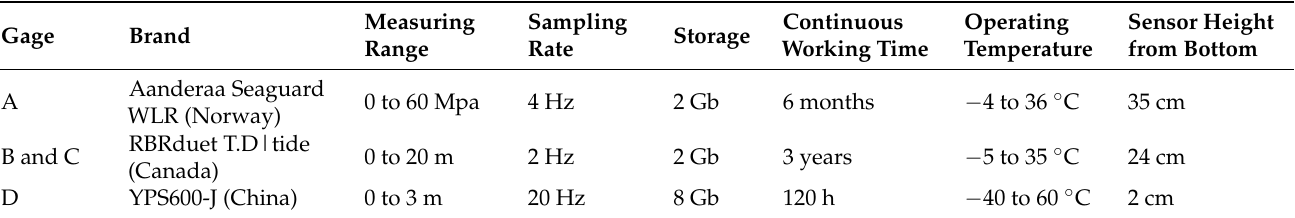
Table 2. Table 2. Basic properties of the pressure gages used in the hydrodynamic